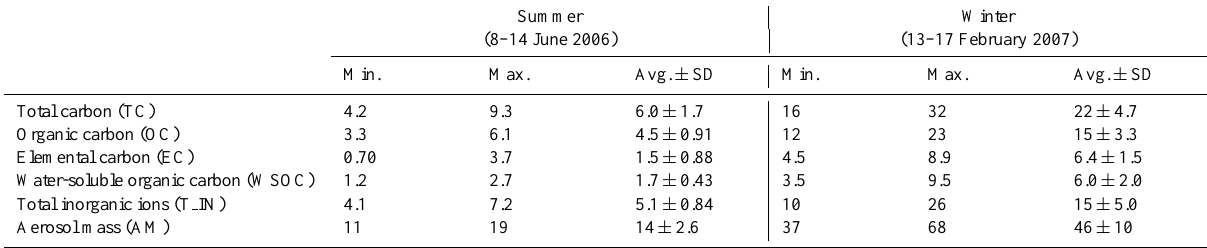
Table 1. Major aerosol constituents (µgm − 3 ) in the Mumbai aerosol samples (PM 10 )